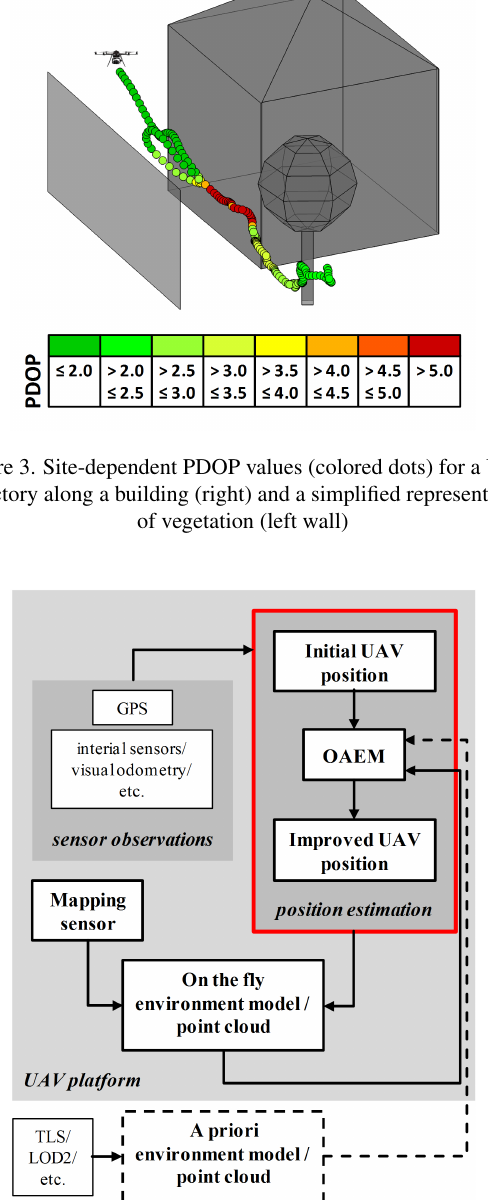
Figure 4. Schematic description of the mobile mapping process including the improved position estimation by using